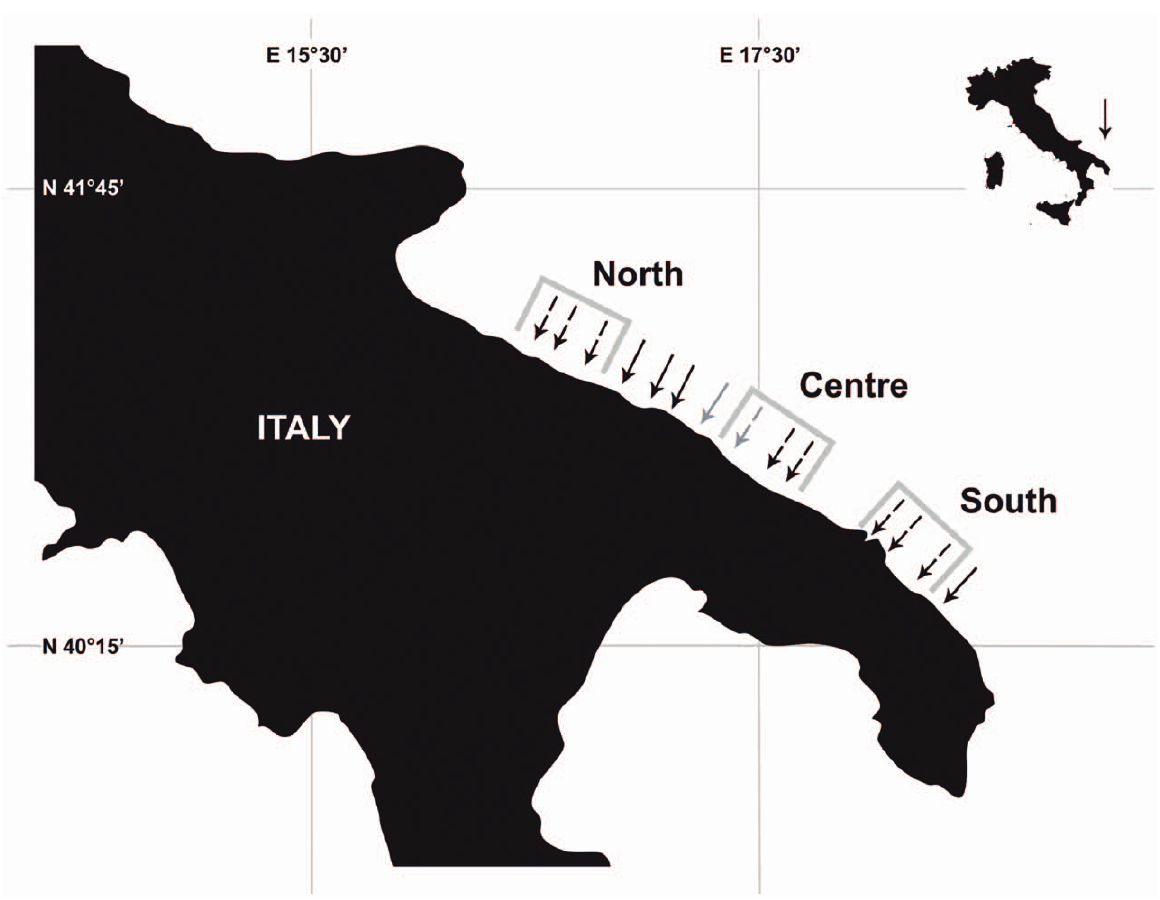
Figure 1. Study area. Arrows represent the 14 sampling sites (in the text numbered progressively from the northern one to the southern one) for settlers and the dotted arrow represents which of these sites are also sampling sites for recruits. Grey arrows indicate sites located inside TGMPA (number 7 and 8). Polygons indicate the three regions considered for the post-settlement dispersal analysis.